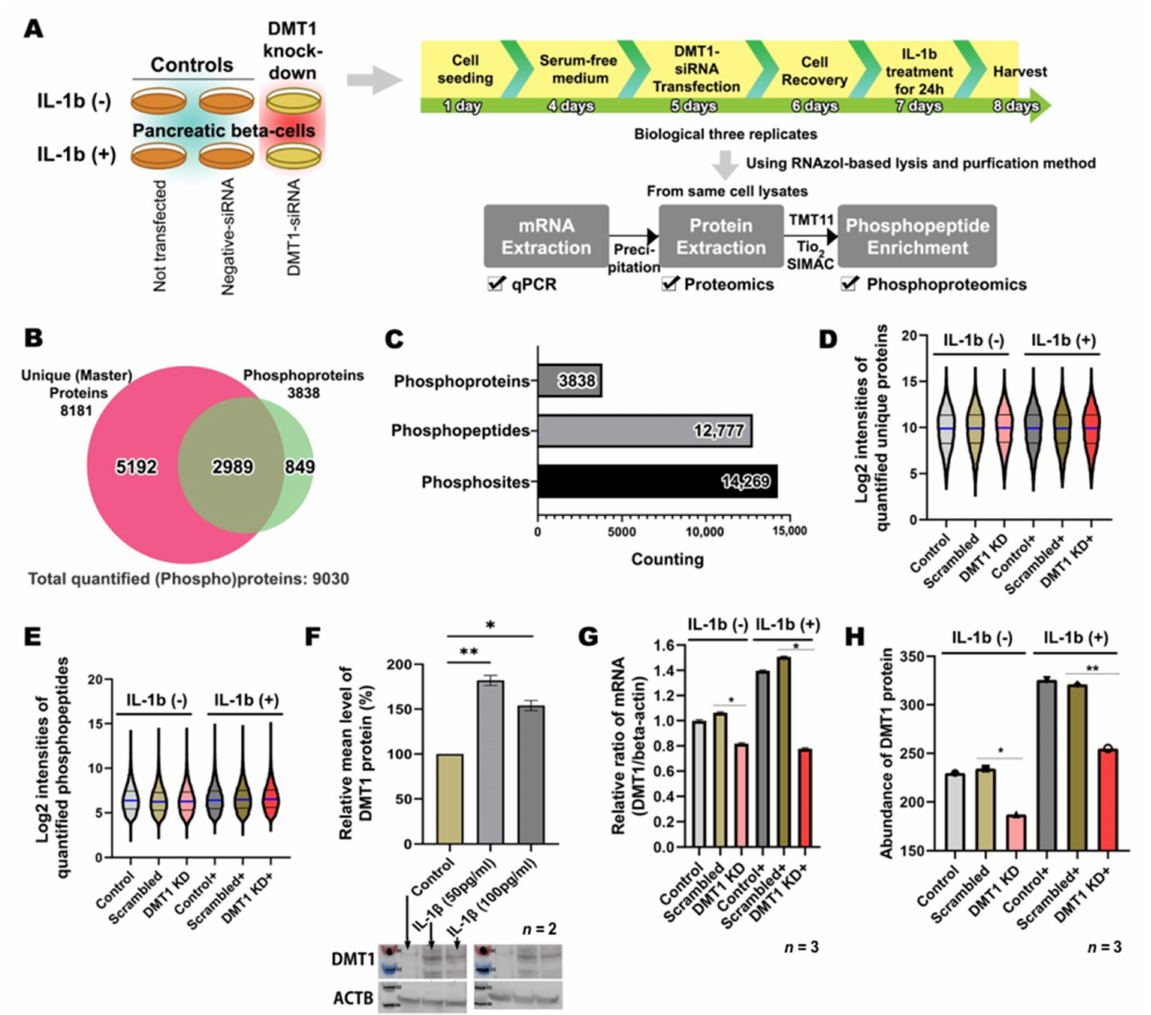
Figure 1. In-depth proteomics and phosphoproteomics profiling of the potential protective effect of iron depletion on inflammation-mediated β -cell dysfunction ( A ) Schematic of experimental designs for integrated proteomics and phos- phoproteomics using a sequential enrichment strategy of mRNA, protein, and phosphopeptides occurring from the same sample. ( B ) Venn diagram representing the overlap between unique (master) proteins and phosphoproteins in β -cells. Approximately 76% of phosphoproteins are overlapped between proteome and phosphoproteome. Unique proteins are not identified in another protein accession number. Unique proteins and phosphopeptides are quantified for further analysis. ( C ) Histogram showing a total of 12,777 phosphopeptides carrying 14,269 high-confident phosphosites (75% < phosphosite localization probability) on 3838 phosphoproteins. ( D ) Violin plot showing the overall distribution of the normalized abundance of quantified unique proteins across six experimental groups. (Blue line: median) ( E ) Violin plot showing the overall distribution of the normalized abundance of quantified phosphopeptides across six experimental groups. (Blue line: median) ( F ) Western blotting finds significantly increased protein production of DMT1 after exposure to IL-1 β (50 and 100 pg/mL). n = 2 biological replicates ( G ) qPCR verify markedly enhanced mRNA expression of DMT1 after IL-1 β treat- ment (50 pg/mL). n = 3 biological replicates ( H ) Proteomics shows the correlation with qPCR results, which DMT1 protein production is increased in the IL-1 β treated β -cell and decreased in DMT1 knock-down β -cells with IL-1 β concentrations. n = 3 biological replicates. * p < 0.05; ** p <